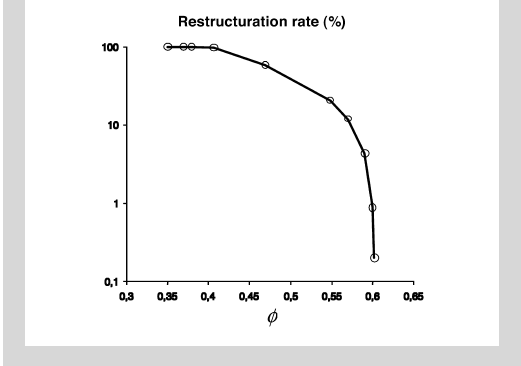
Figure 3: Rate of restructuring as a function of f . The fall is more and more abrupt as f increases above f (here f c2 c2 = 0.406) and becomes extremely steep as f ô f . m Same values of NLS-model parameters as in Figure 1, ª 2·10 4 with k t A0 fin